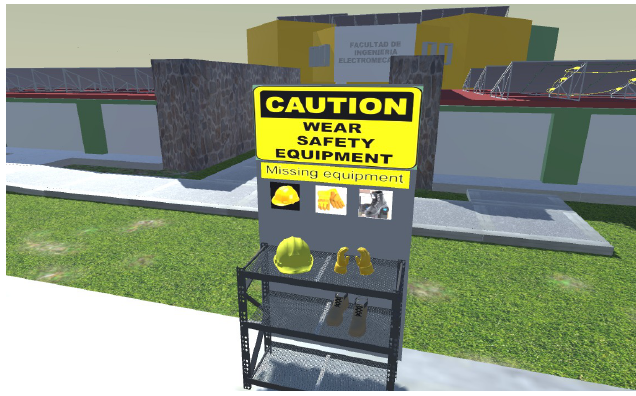
Figure 3. Personnel safety equipment.